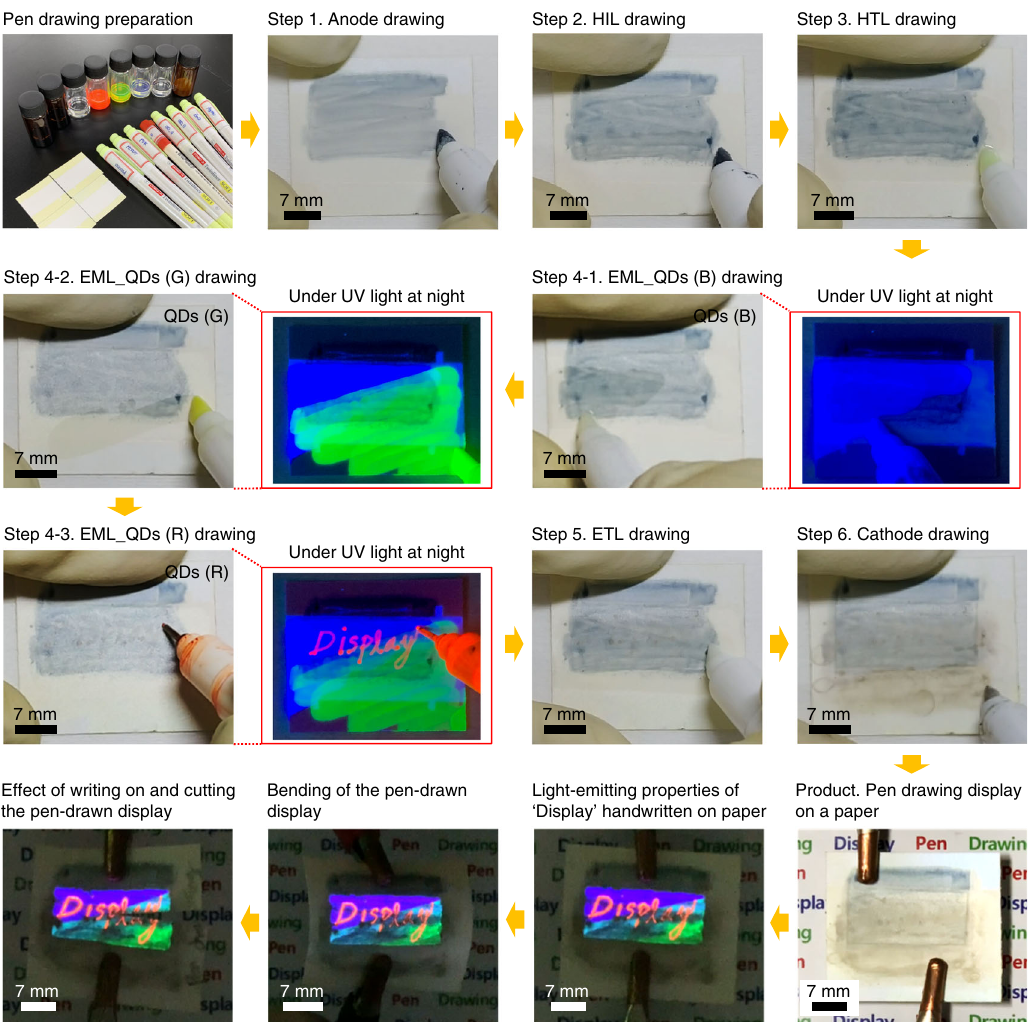
Fig. 7 Handwriting images using the pen-drawing method. Photo images of “ Display ” handwritten on paper, showing the light-emitting ability, mechanical fl exibility, and tearing